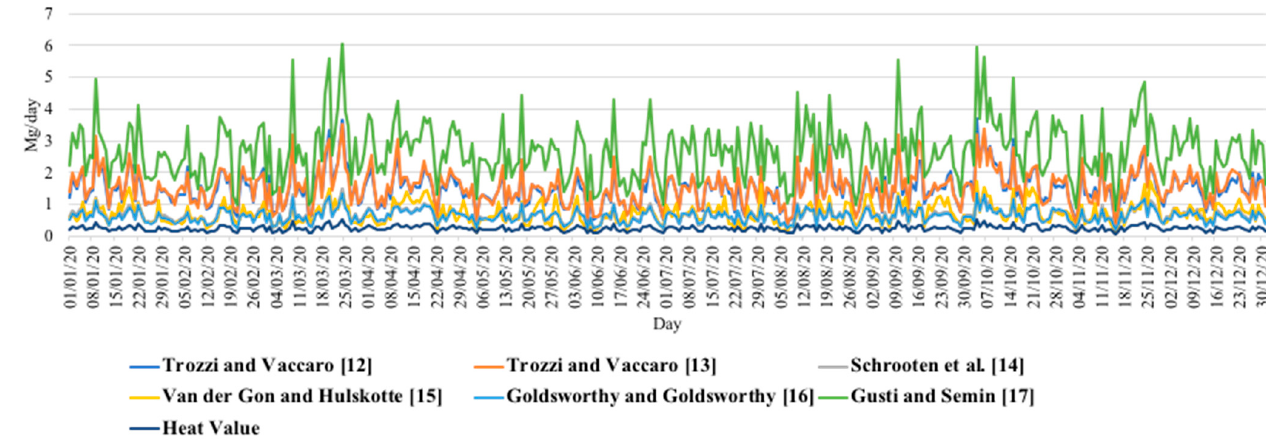
Figure 5. Total atmospheric SO 2 emissions (Mg/day), berthing + maneuvering position, for each method.